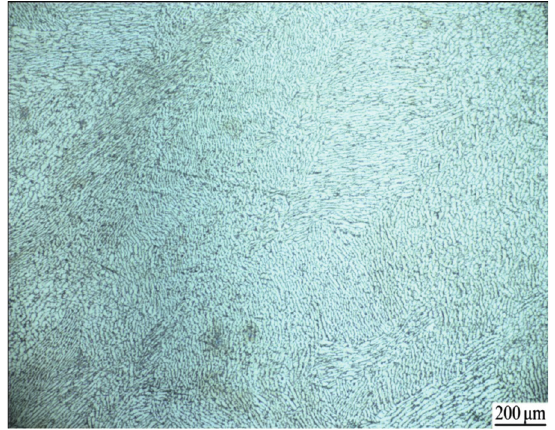
Figure 12 : Microstructure manifestation of instability in Ti – 6Al – 4V alloy at 1,023 K and 10 s − 1